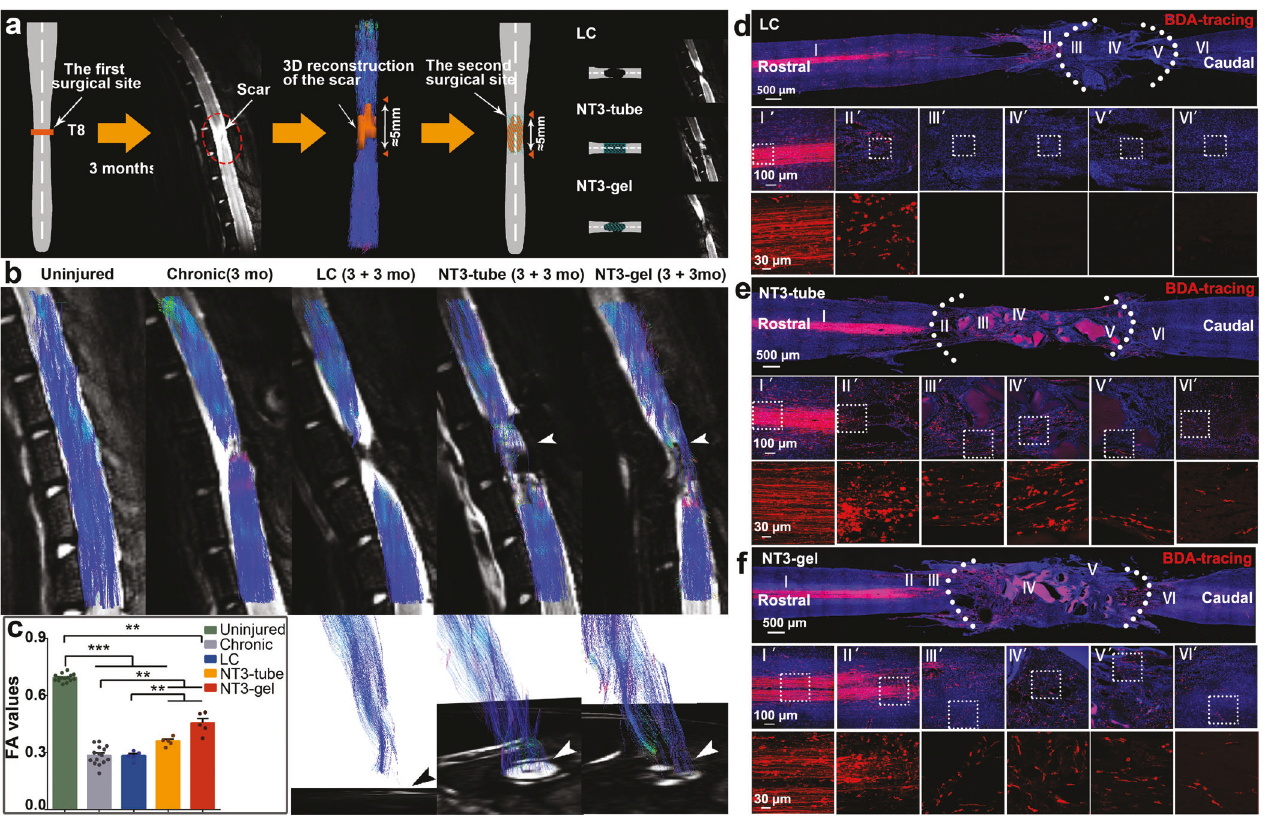
Fig. 3 DTI indicating neural tissue regeneration after chronic SCI by NT3-tube and NT3-gel. a Diagram illustrating establishment of chronic-SCI models, removal of glial scars, and differences among three different groups (LC, NT3-tube, and NT3-gel). b Typical fi ber tract reconstructions in Uninjured, Chronic, LC, NT3-tube, and NT3-gel treated spinal cords are displayed. Only NT3-tube and NT3-gel animals demonstrate regenerated fi ber bundles (white arrowheads) extending across the surgical site, while LC animals showed no fi bers passing through the lesion area. Red lines indicate the region of interest (ROI) of the spinal cord. Lower panel demonstrated DTI fi ber tracks over axial images for LC, NT3-tube, and NT3-gel groups. c Bar graph of averaged FA values of fi ve groups was displayed. FA values were extracted and calculated from each animal ’ s ROI. V, ventral; D, dorsal; L, left; R, right; ** P < 0.01; *** P < 0.001, by ANOVA ( F value = 272.39445). Shown are mean ± SEM. Number of animals: uninjured stage, n = 15, chronic stage, n = 15, and LC, NT3-tube, NT3-gel groups after the second operation, n = 5 for each group. See Supplementary Table 2 for exact P values. d – f CST tracking with unilateral cortical BDA injections in LC, NT3-tube, and NT3-gel groups at 3 mo after the second